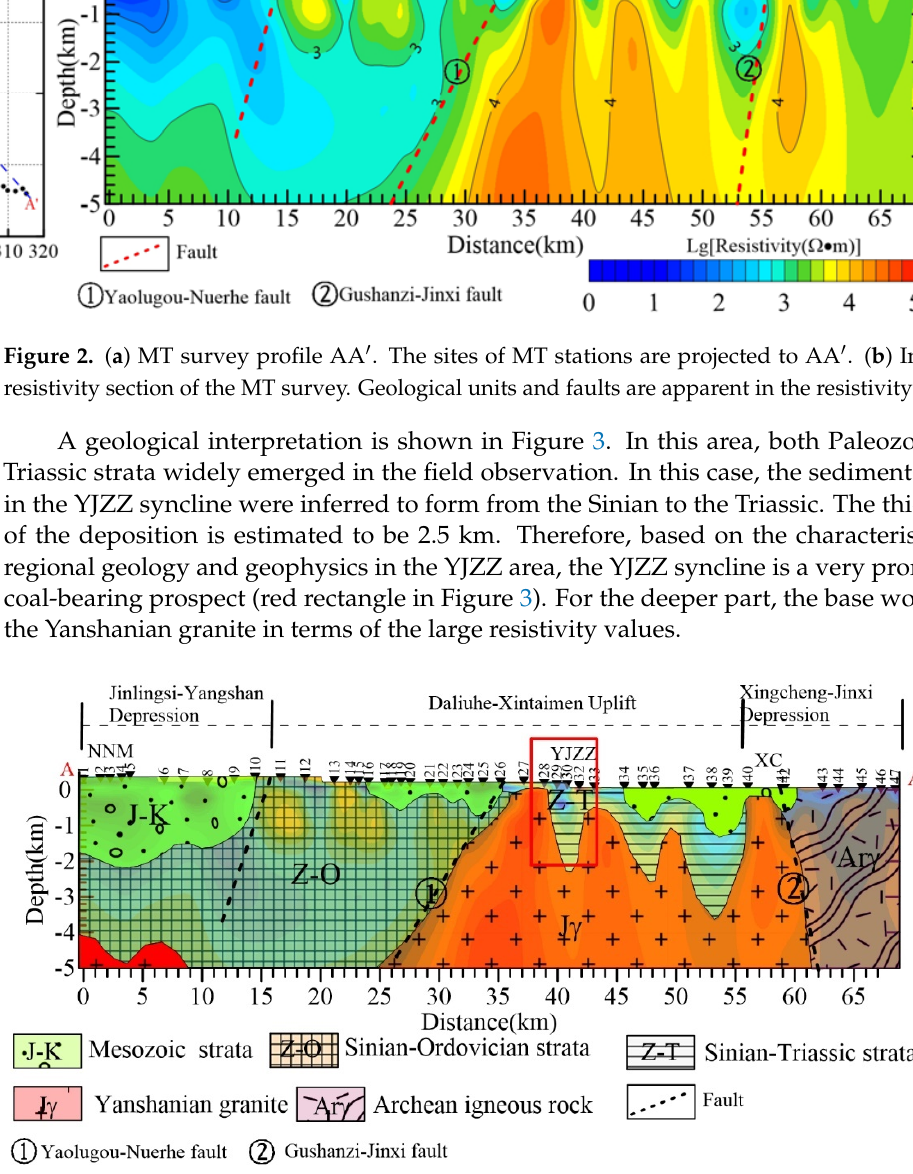
Figure 3. Geological interpretation of the MT inversion results.